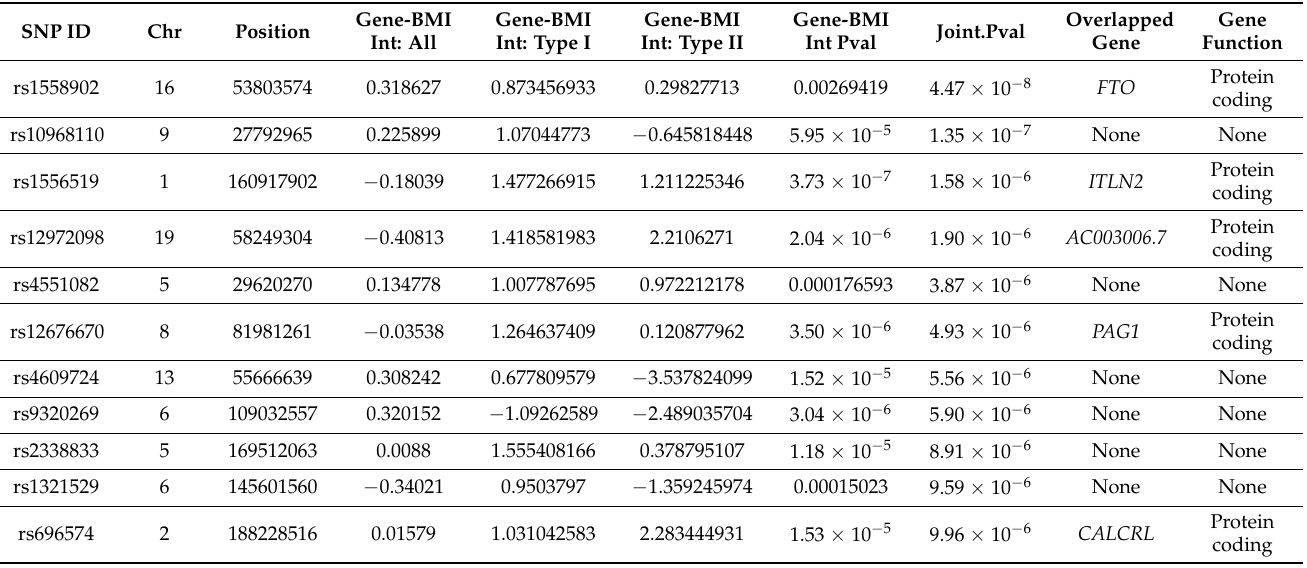
Table 1. GWAS results for the interaction effect between body mass index (BMI), single nucleotide polymorphisms (SNPs), and type I and II of psoriasis *.